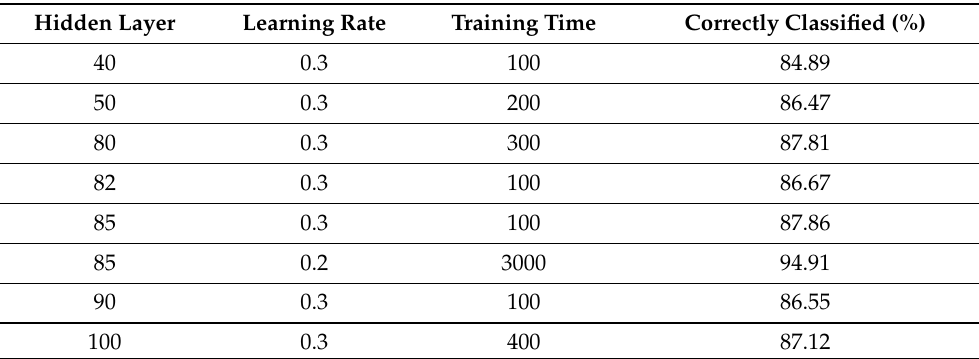
Table 1. Parameters used for ANN training.